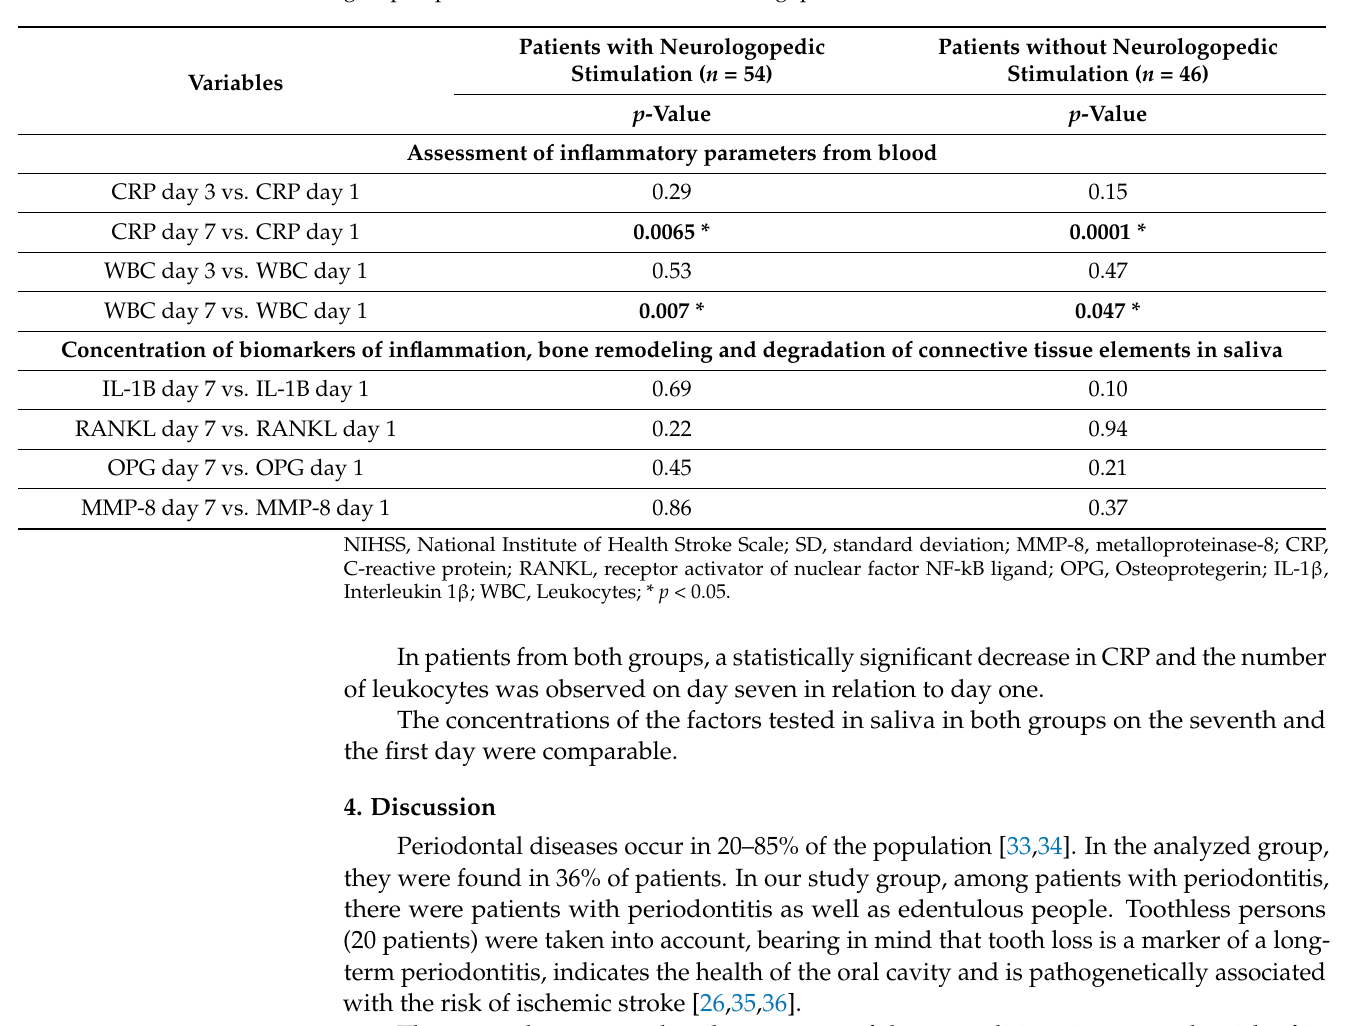
Table 5. The differences between the following time points and day 1 (baseline) of CRP level and white blood cells in the blood and Il-1 β , RANKL, OPG and MMP-8 concentration in saliva in the group of patients with and without neurologopedic